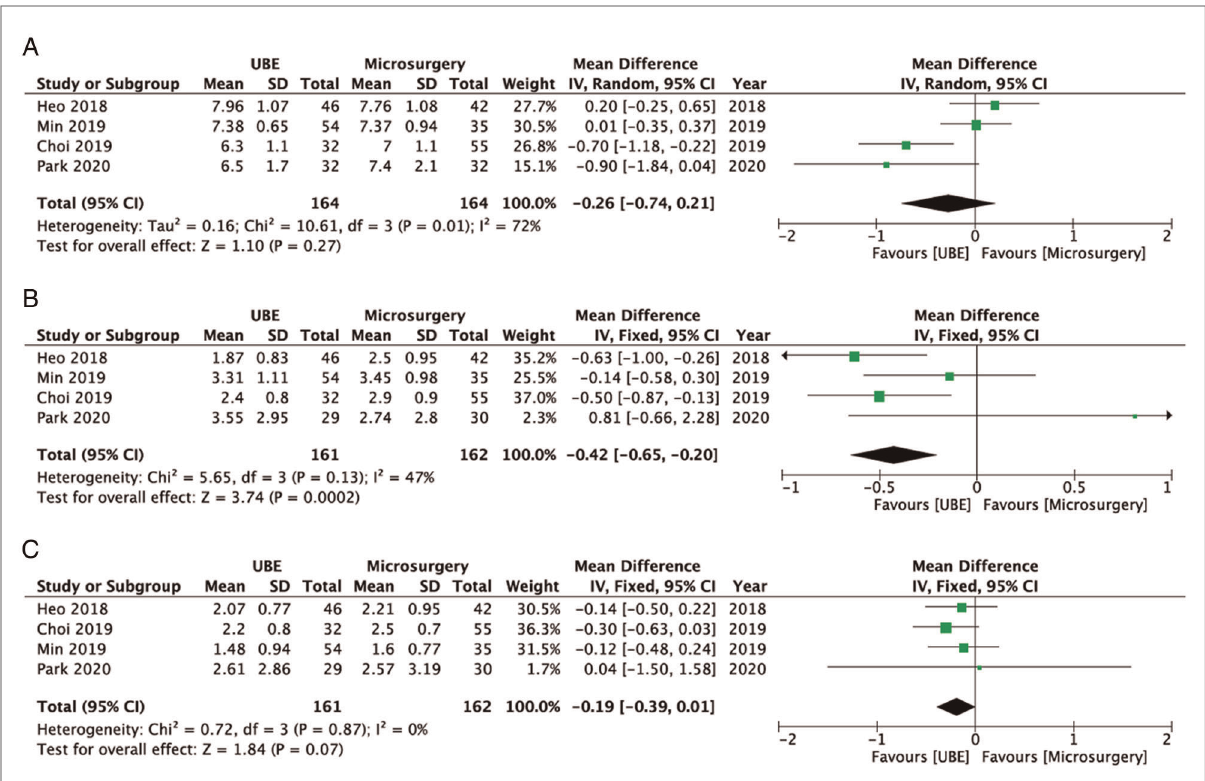
FIGURE 6 Forest plots for comparison of VAS for leg at preoperative ( A ), early (<3 months) postoperative ( B ), and fi nal follow-up ( C ) between UBE ULBD and microscopic ULBD. VAS, visual analog scale; UBE, unilateral biportal endoscopic; ULBD, unilateral laminectomy with bilateral